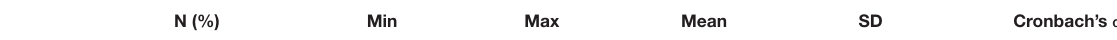
TABLE 1 | Descriptive analysis of all